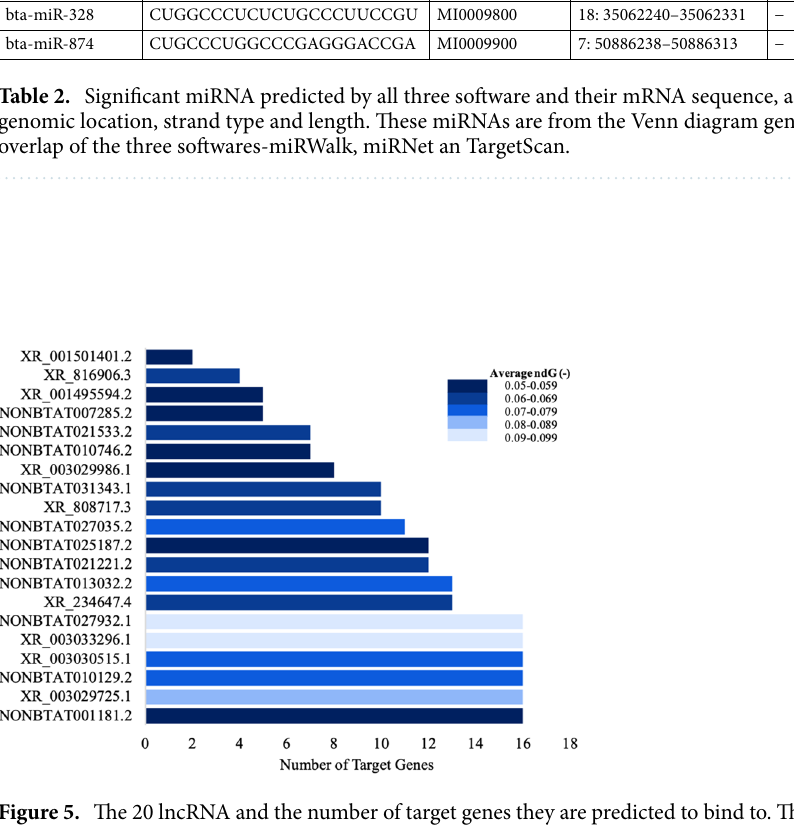
Figure 5. The 20 lncRNA and the number of target genes they are predicted to bind to. The darkest shade of blue corresponds to the lowest (-) ndG and the lightest shade of blue corresponds to the highest (-) ndG. Figure created with Microsoft Excel (2013) (https:// www. micro soft. com/ en- us/ micro soft- 365/